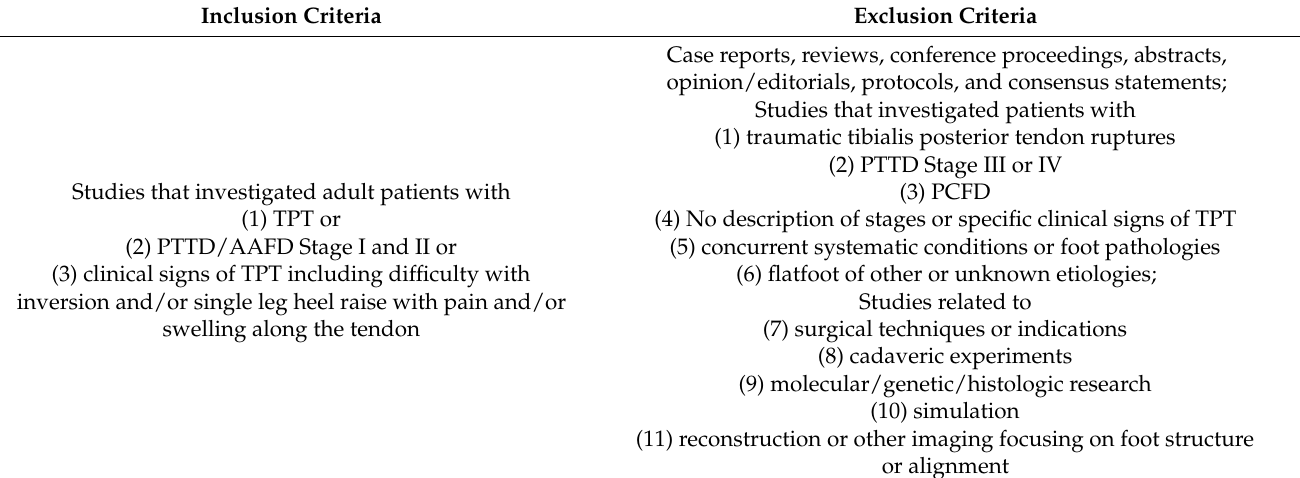
Table 1. Inclusion and exclusion criteria for study